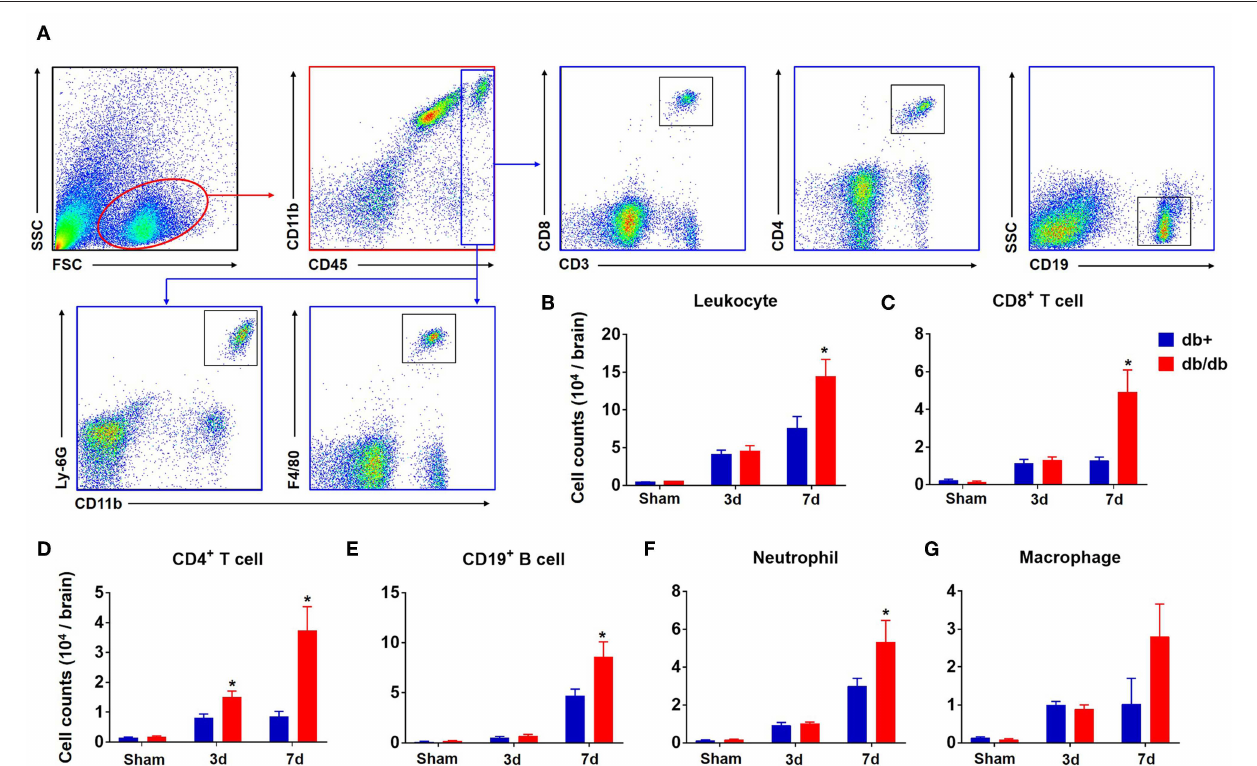
FIGURE 1 | Augmented brain infiltration of leukocyte subsets in db/db mice subjected to dMCAO assessed by flow cytometry. Groups of db/db or db/ + mice were subjected to sham or dMCAO surgery. Single-cell suspensions were prepared from brain tissues of indicated groups of mice. (A) Gating strategy of peripheral leukocytes (CD45 + ), including macrophages (CD45 high CD11b + F4/80 + , M ϕ ), neutrophils (CD45 high CD11b + Ly-6G + ), CD4 + T (CD45 high CD3 + CD4 + ), CD8 + T (CD45 high CD3 + CD8 + ), and B (CD45 high CD19 + ) cells in the ischemic brain at day 3 and day 7 after dMCAO. (B–G) Quantification of brain-infiltrating lymphocytes, macrophages and neutrophils from sham and distal MCAO db/ + and db/db mice at indicated time points after ischemia. Data are expressed as mean ± s.e.m. * p < 0.05: db/ + vs. db/db at the same time point, n = 8 per group.